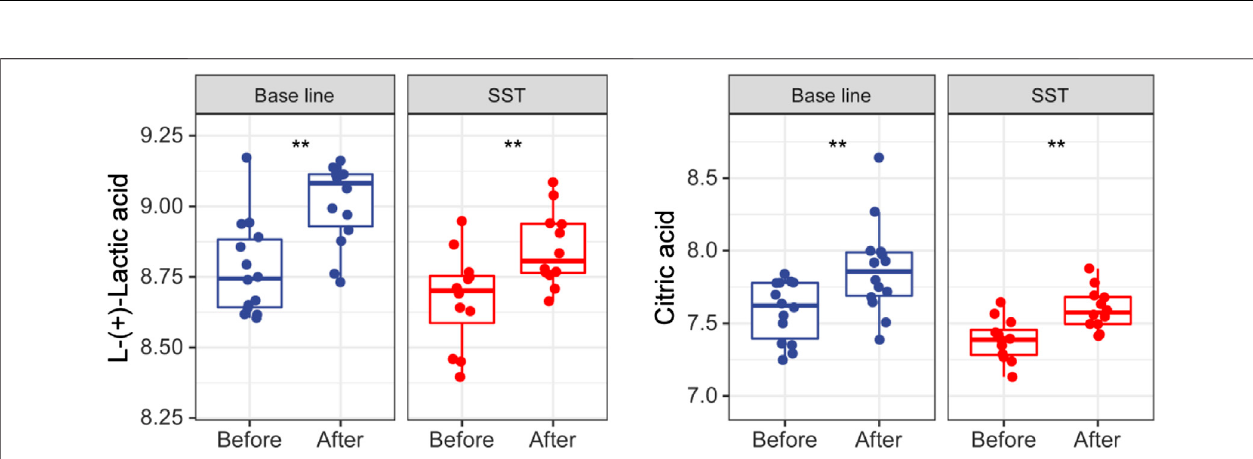
FIGURE 6 | Levels of glucose metabolism related metabolites in serums of breast cancer patients receiving base-line chemotherapy or adjuvant SST treatment. ** p < 0.01 by student ’ s t test.